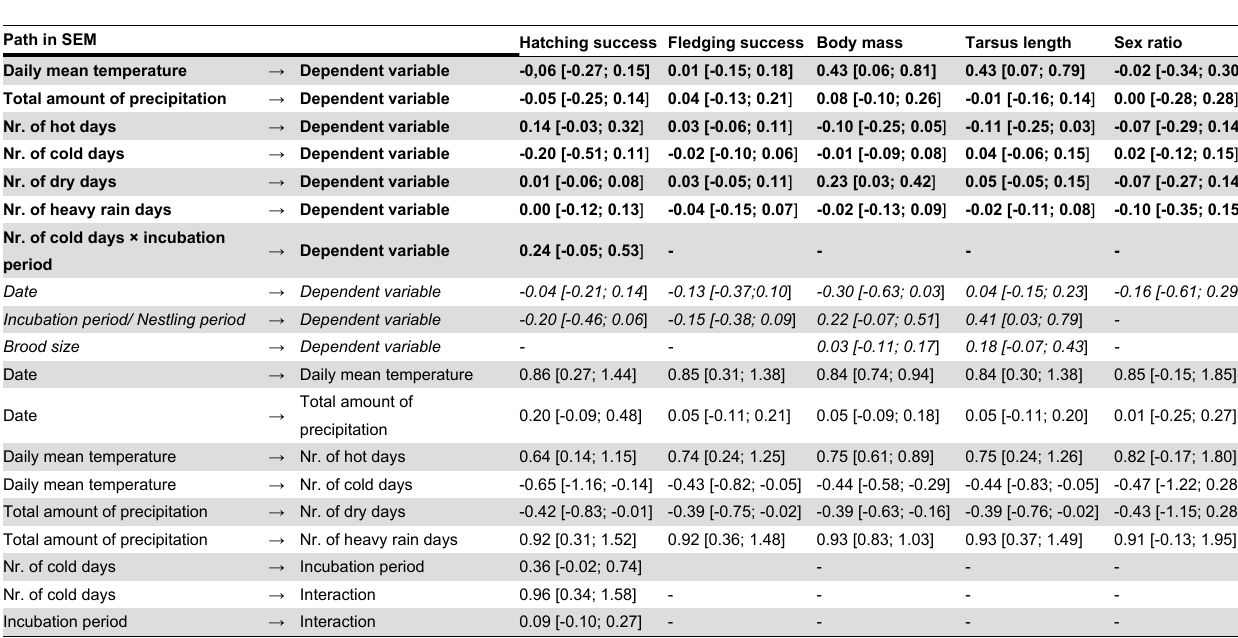
Table 1. Model-averaged parameter estimates [95% confidence intervals] for five measures of reproductive success as dependent